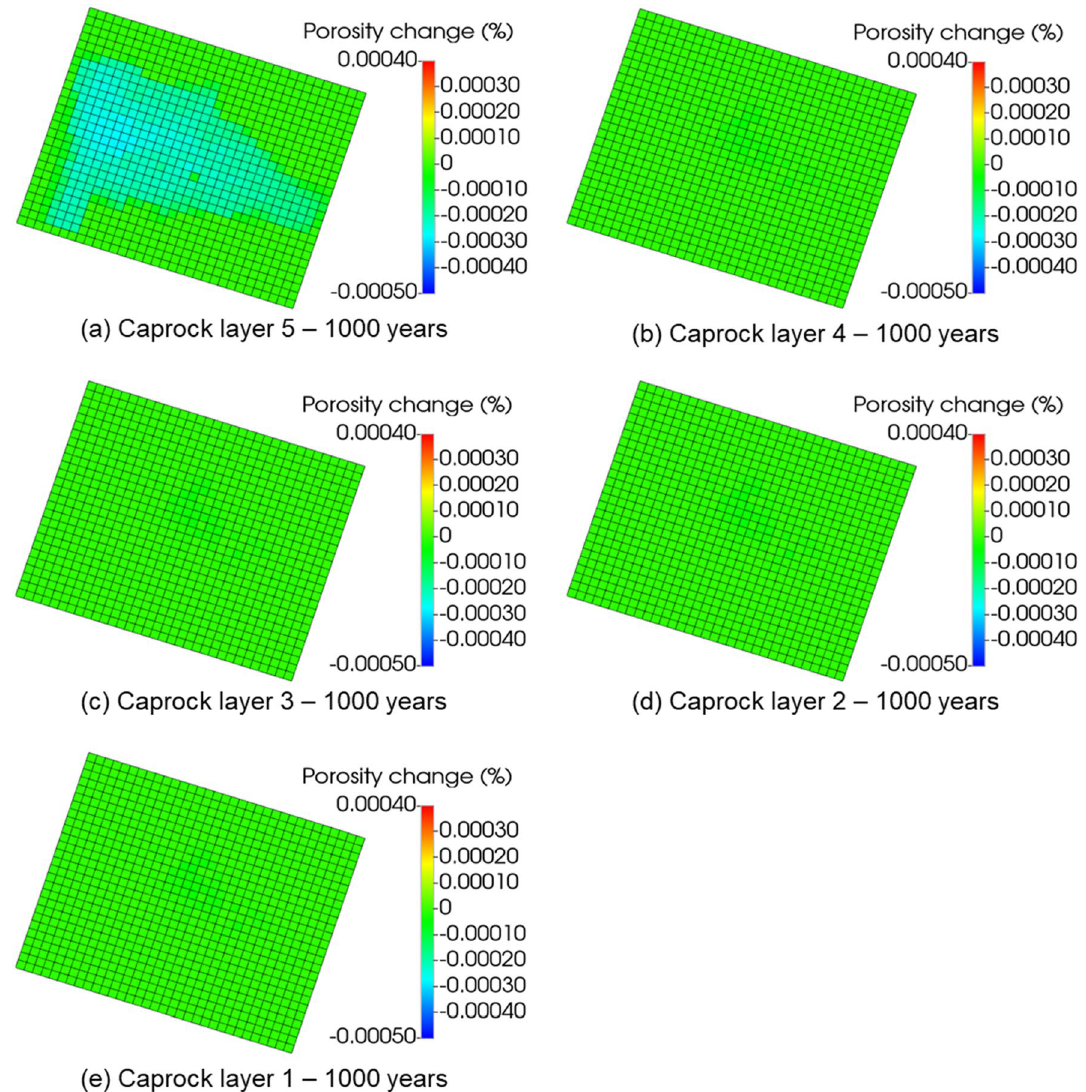
Figure 10. The porosity changes within the caprock layers at the end of the 1000 years of post-injection